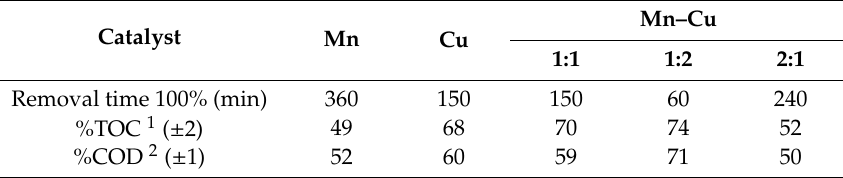
Table 4. Catalytic activity in CV degradation of Mn–Cu catalyst.